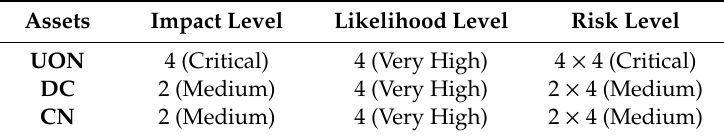
Table 3. Risk Levels for SMiShing